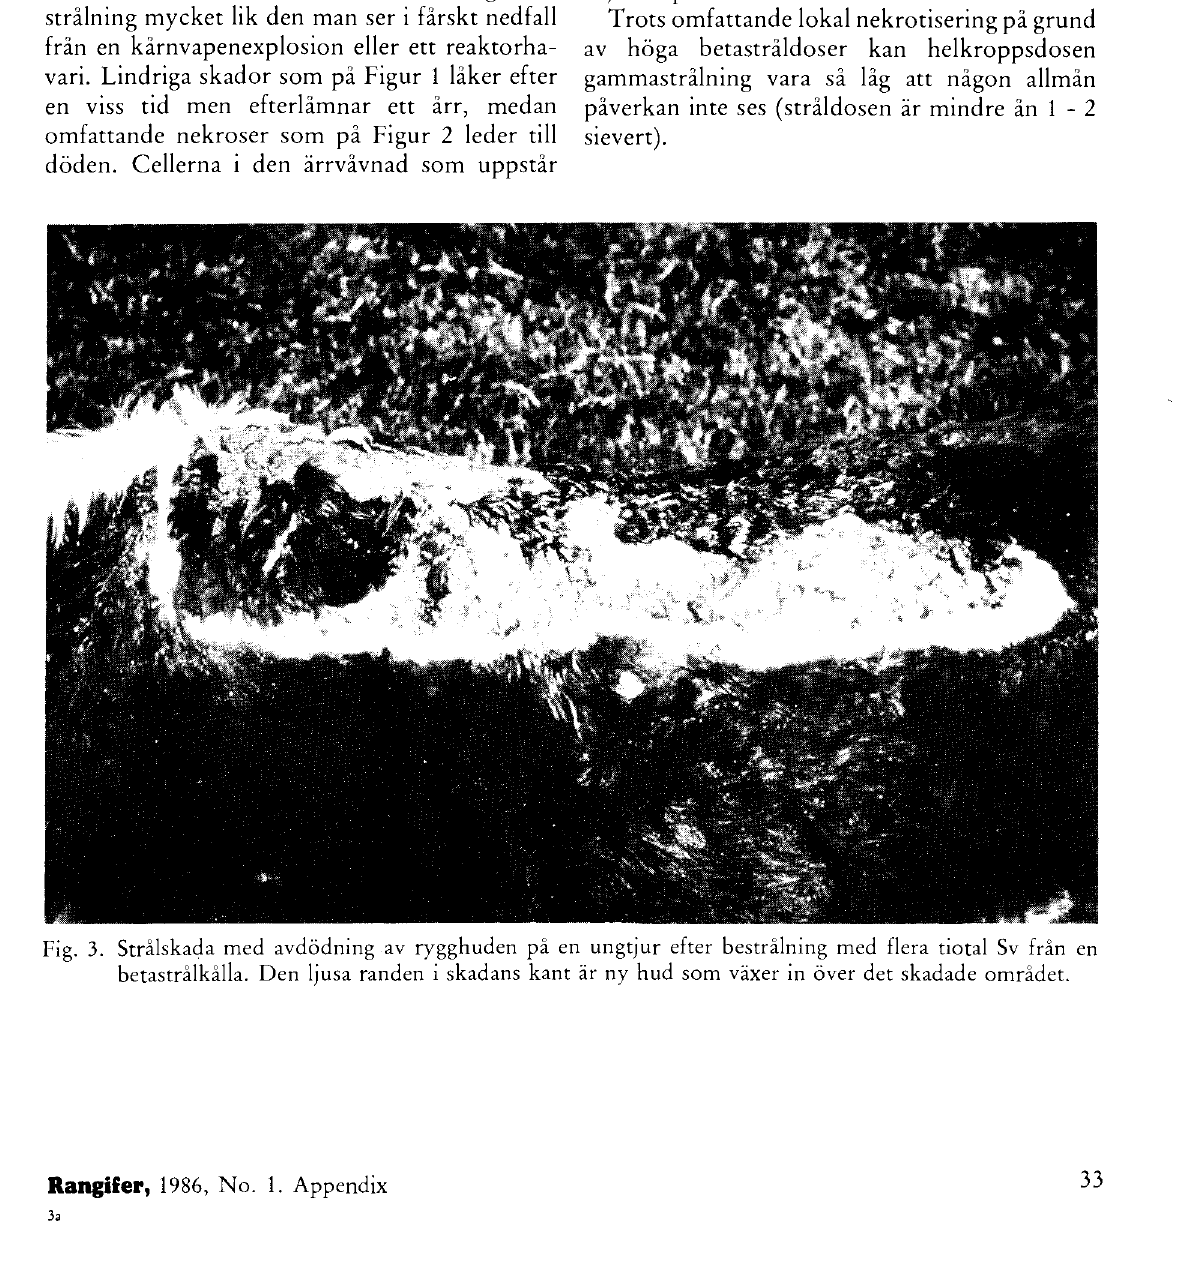
Fig. 3. Strålskada med avdödning av rygghuden på en ungtjur efter bestrålning med flera tiotal Sv från en betastrålkålla. Den ljusa randen i skadans kant är ny hud som växer in över det skadade